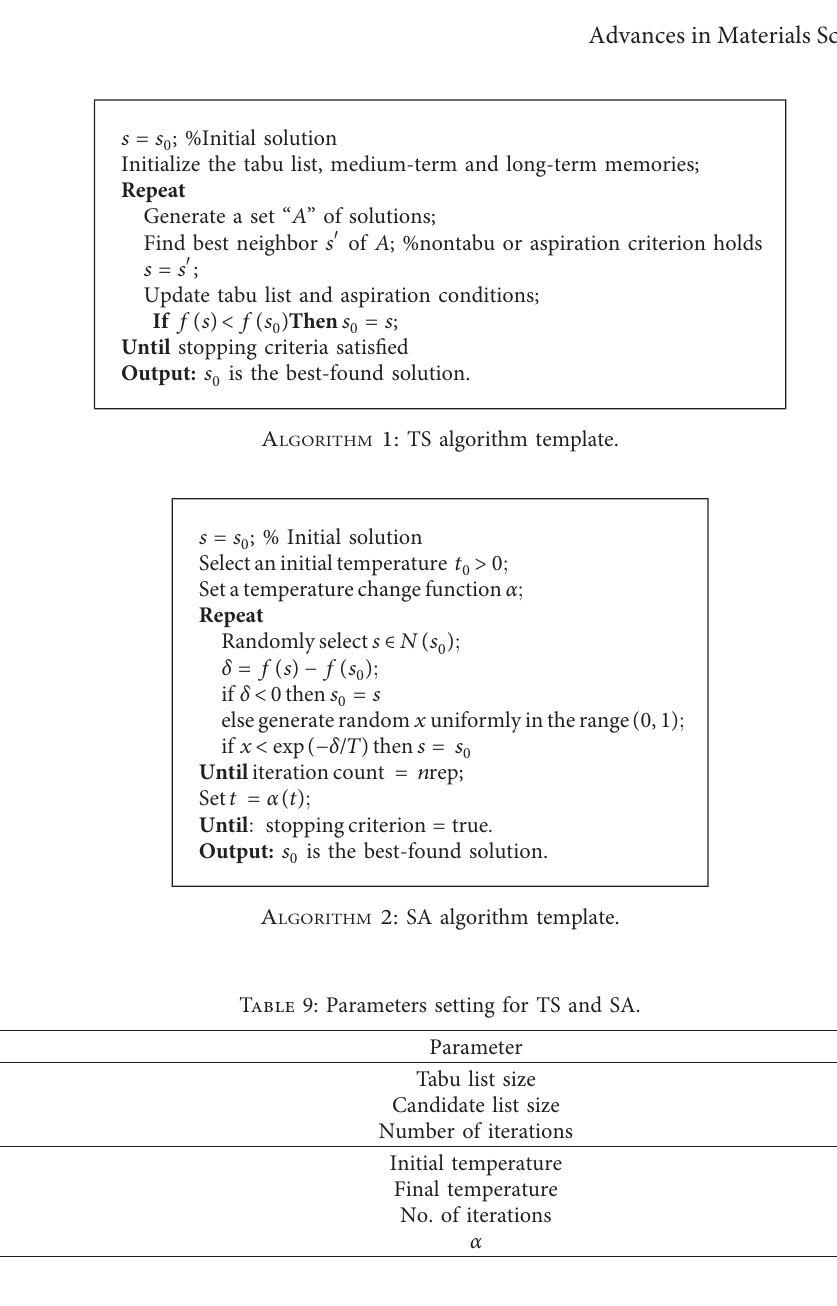
Table 10: Best condition for achieving the optimum vibration and chip frequency by Minitab optimizer, TS, and SA.